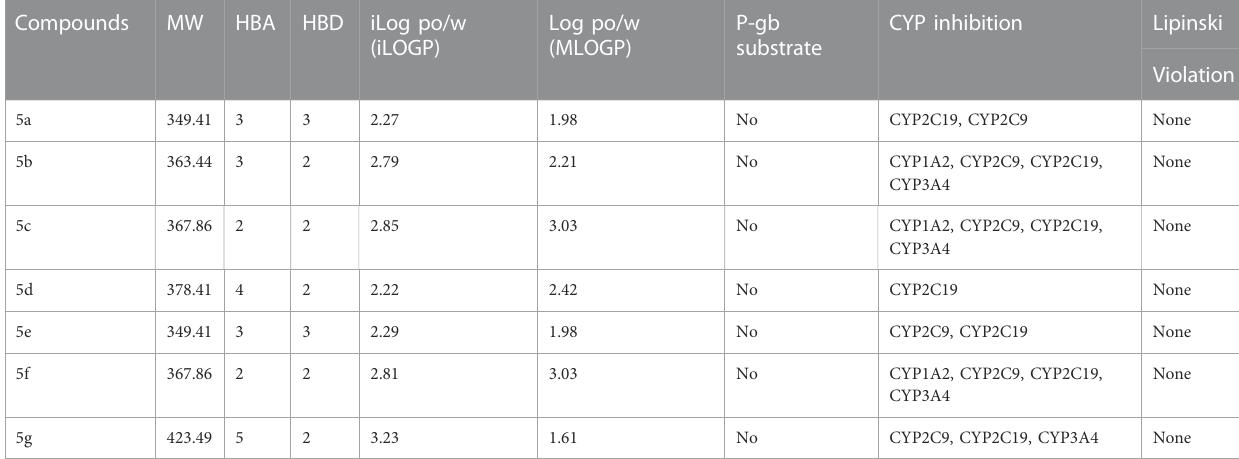
TABLE 1 Lipinski ’ s Rule of fi ve for Drug Likeliness of compounds 5a-5g.